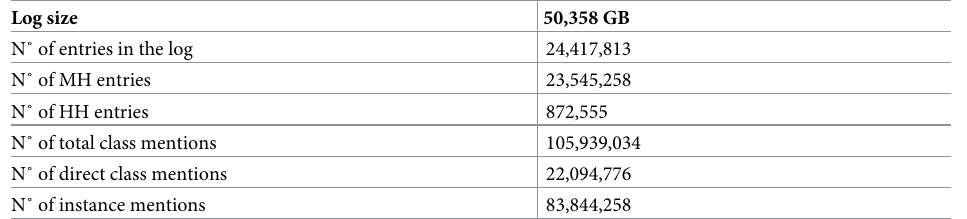
Table 3. Statistics about the Wikidata SPARQL logs